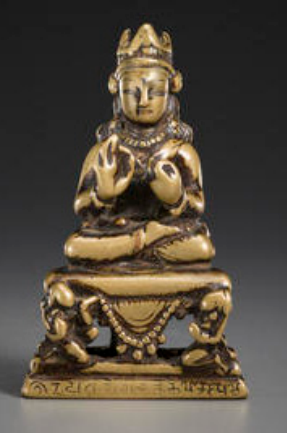
Figure 38. Vairocana Buddha wearing a crown and jewelry performing the dharmacakra-pravartana mudr ā , seventh to eighth c. Gilgit or Kashmir. Brass with silver and copper inlay. https://himalayanbuddhistart.files.wordpress.com/2015/08/7th-8th-c-gilgit-vairocana-brasssil-eyescop-